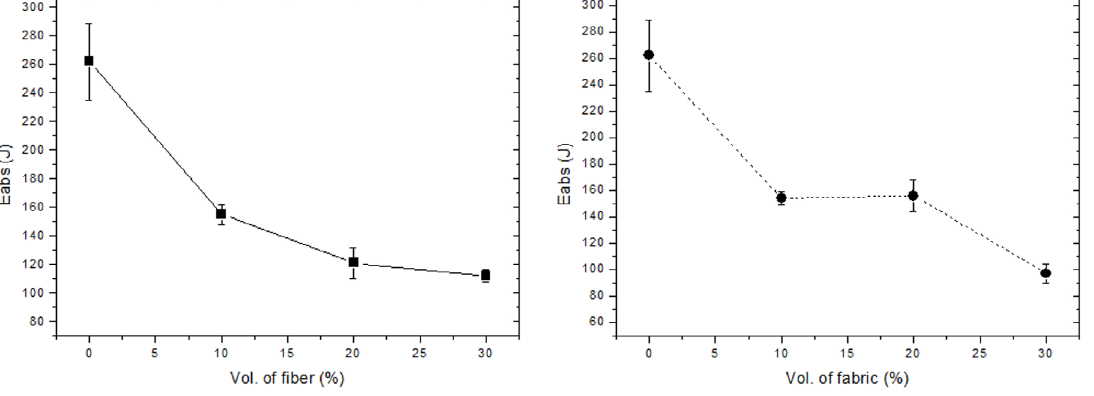
Figure 3. Relation between to the energy absorbed (E volume fraction of fique fiber.